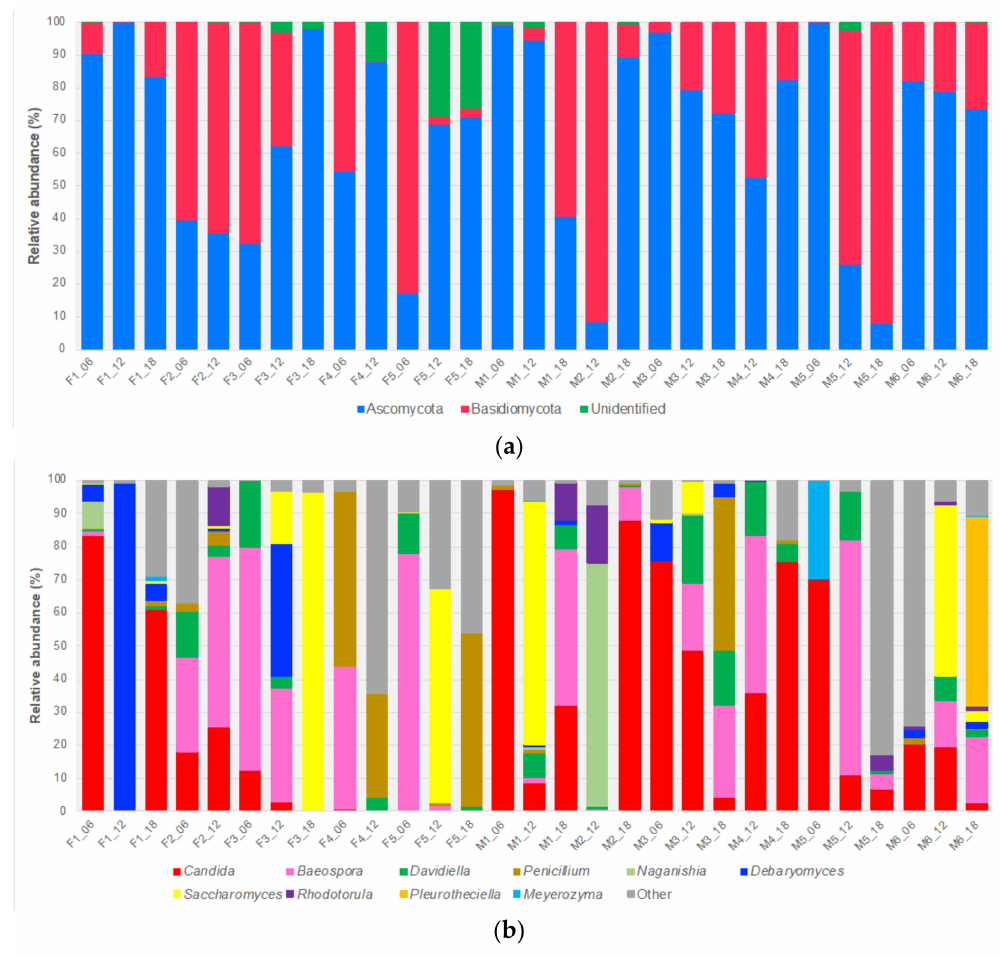
Figure 1. Bar charts of the relatively most abundant fungal taxa in the preterm infant gut at ( a ) phylum level and ( b ) genus